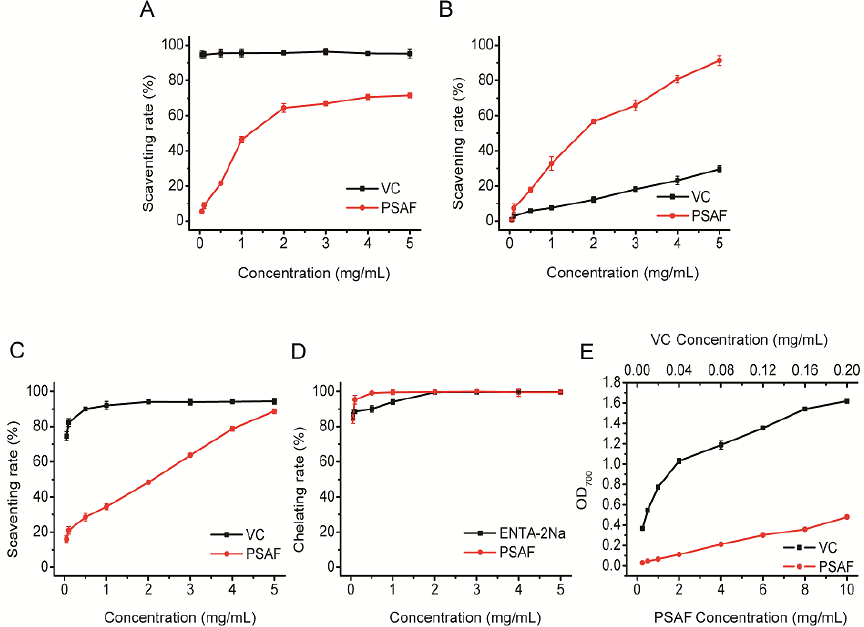
Figure 6. Antioxidant activities of PSAF in vitro. Scavenging effects on DPPH radical ( A ), hydroxyl radical ( B ), superoxide radical ( C ) and Fe 2+ chelating activity ( D ) and reducing power ( E ).